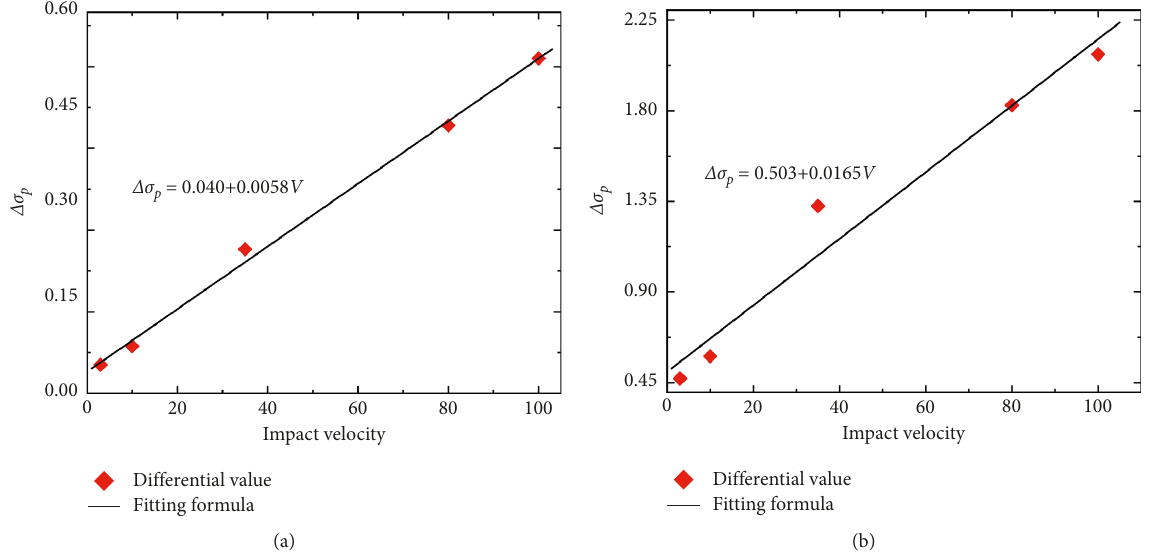
Figure 10: Differences of plateau stress for (a) Δ ρ � 4.4% and (b) Δ ρ � 8.8%.